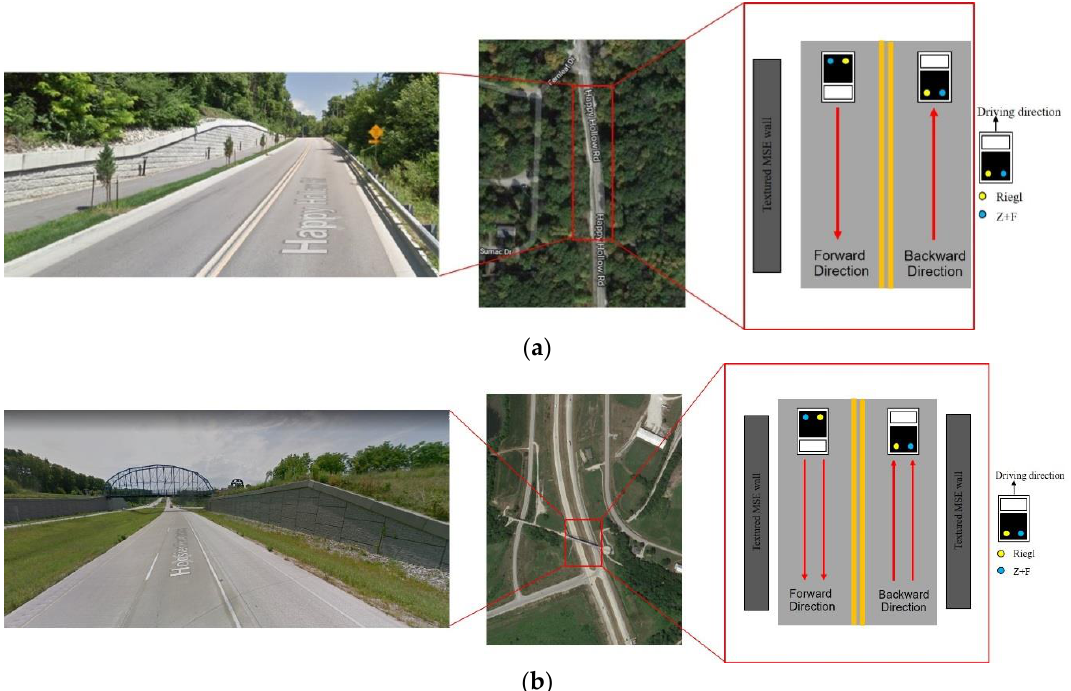
Figure 7. Location and drive-run configuration for the dataset collection at ( a ) Site-1 and ( b ) Site-2.